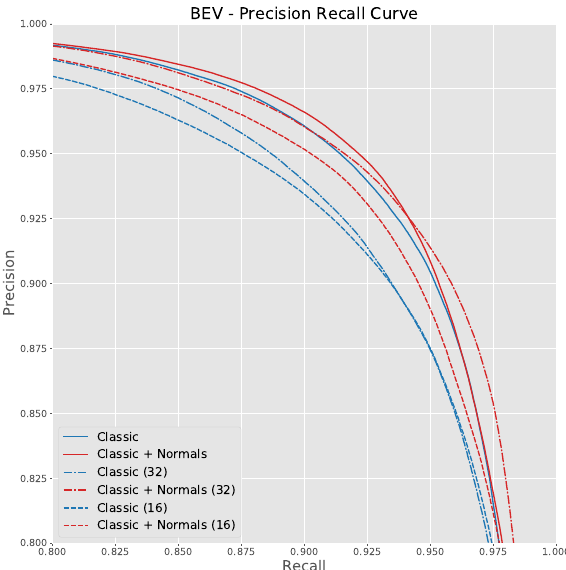
Figure 8. KITTI Road Segmentation with BEV images: Precision-Recall Curve for various features with and without sub-sampling.